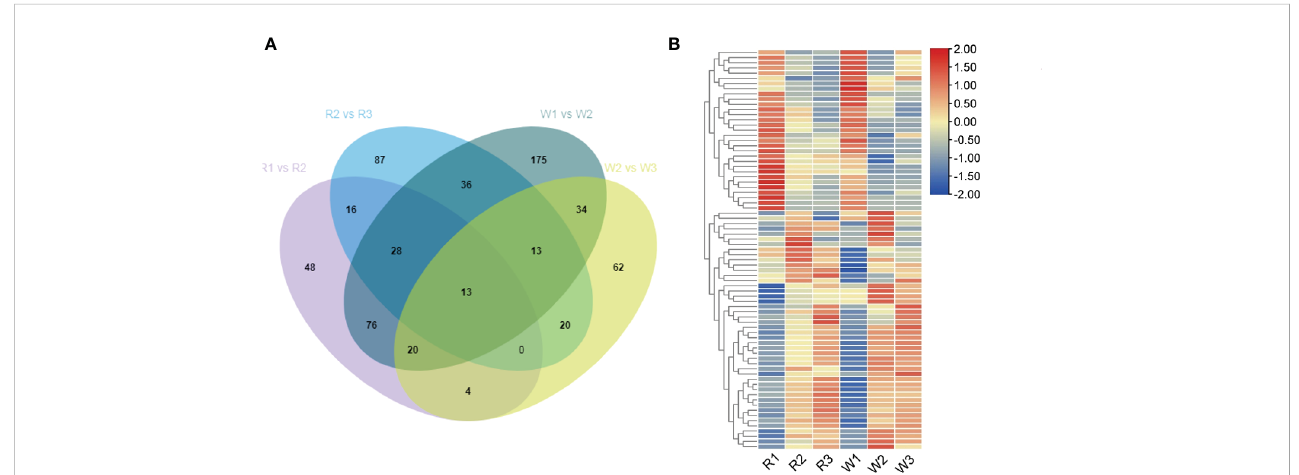
FIGURE 3 Analysis of the differentially expressed genes (DEGs) of the plant hormone pathway in red (R) and white (W) nut fl owers at different development stages. (A) Venn diagram of the DEGs related to the plant hormone pathway in four comparison groups. (B) Analysis of the DEGs in the different development stages of nut fl owers. In the Venn diagram, the numbers represent the shared or unique DEG counts in the different comparison groups. In the heat map, the red and blue colors represent upregulated and downregulated gene expression,